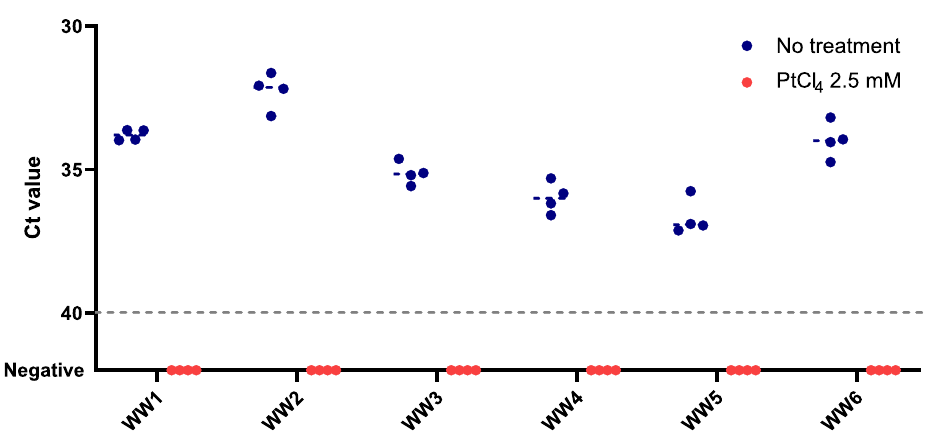
Figure 5. Validation of 2.5 mM PtCl 4 viability RT-qPCR on ten-fold diluted naturally contaminated wastewater samples. Dashed grey line represents RT-qPCR theoretical limit of